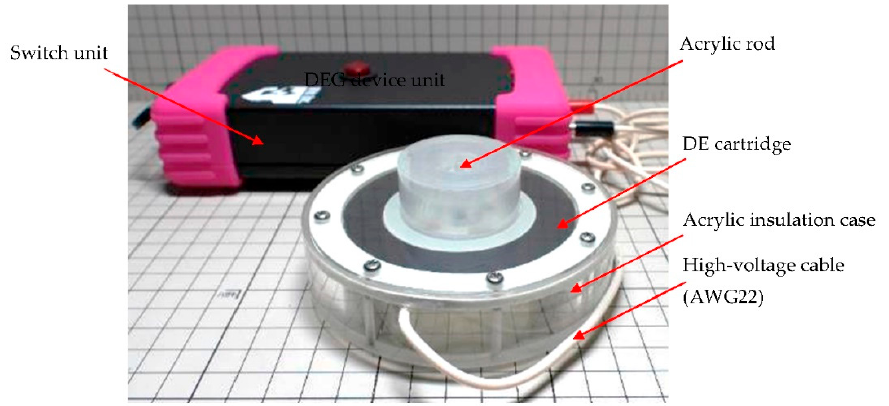
Figure 16. The small DEG device.